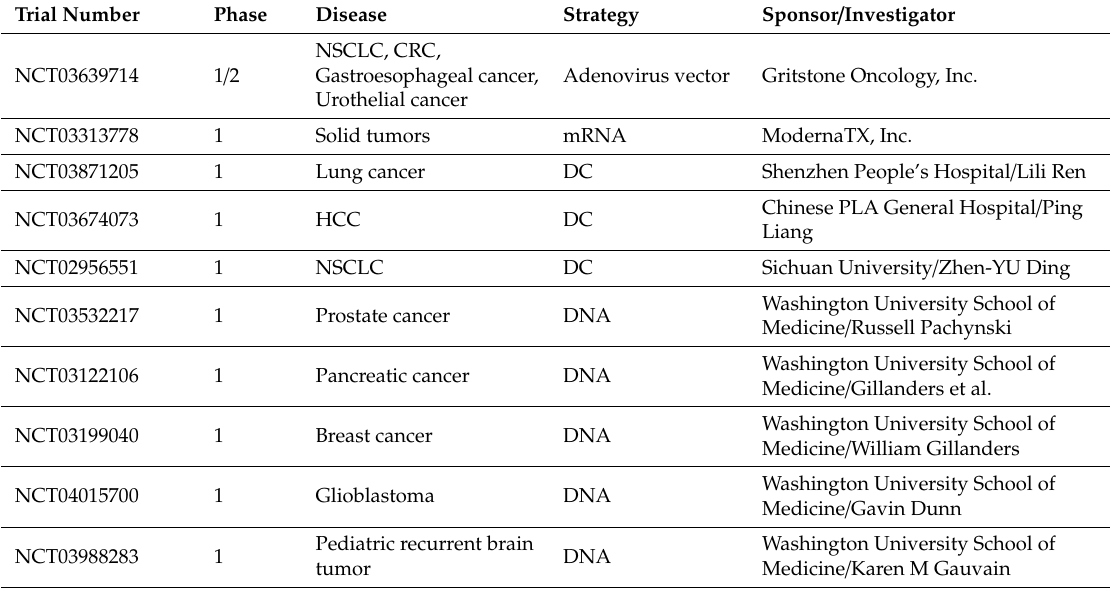
Table 2. Ongoing clinical trials with neoantigen cancer